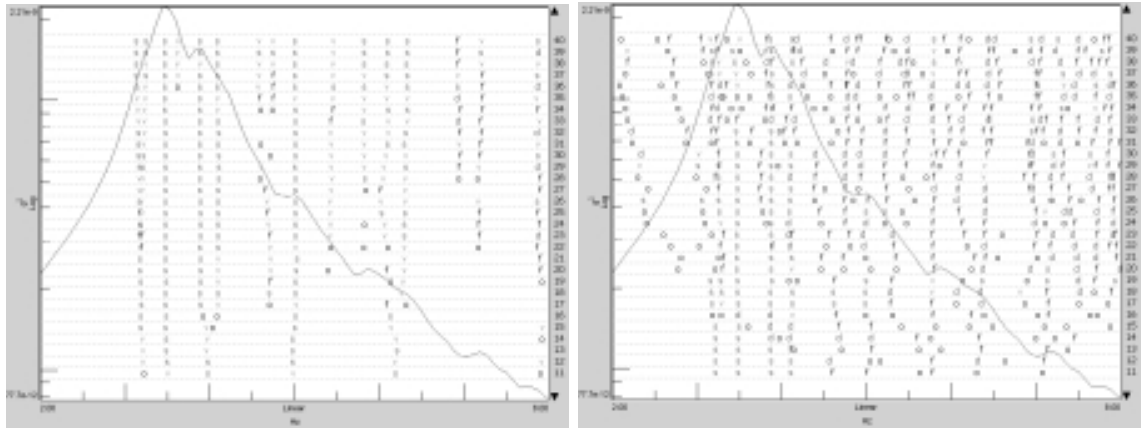
Fig. 7. Stabilisation diagram obtained by applying PolyMAX (Left) and Stochastic Subspace Identification (Right) to the complete data set.